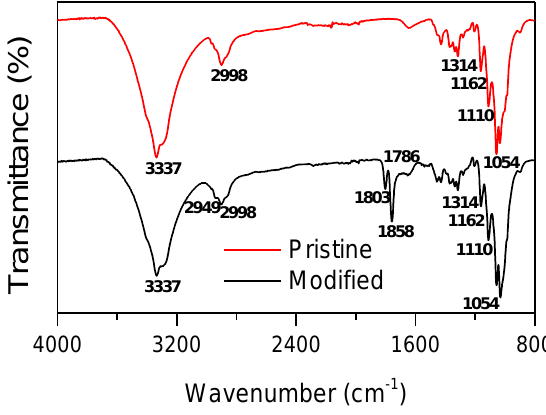
Figure 4. FTIR spectra of the pristine and modified cotton Figure 4 . FTIR spectra of the pristine and modified cotton fabric. Figure 4 . FTIR spectra of the pristine and modified cotton fabric.